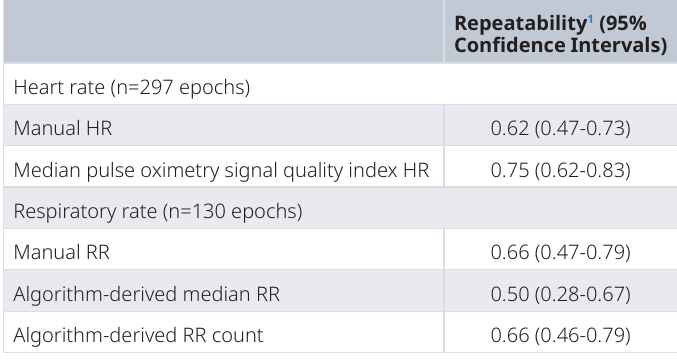
Table 5. Repeatability results for heart rate (HR) and respiratory rate (RR) measurements for all included